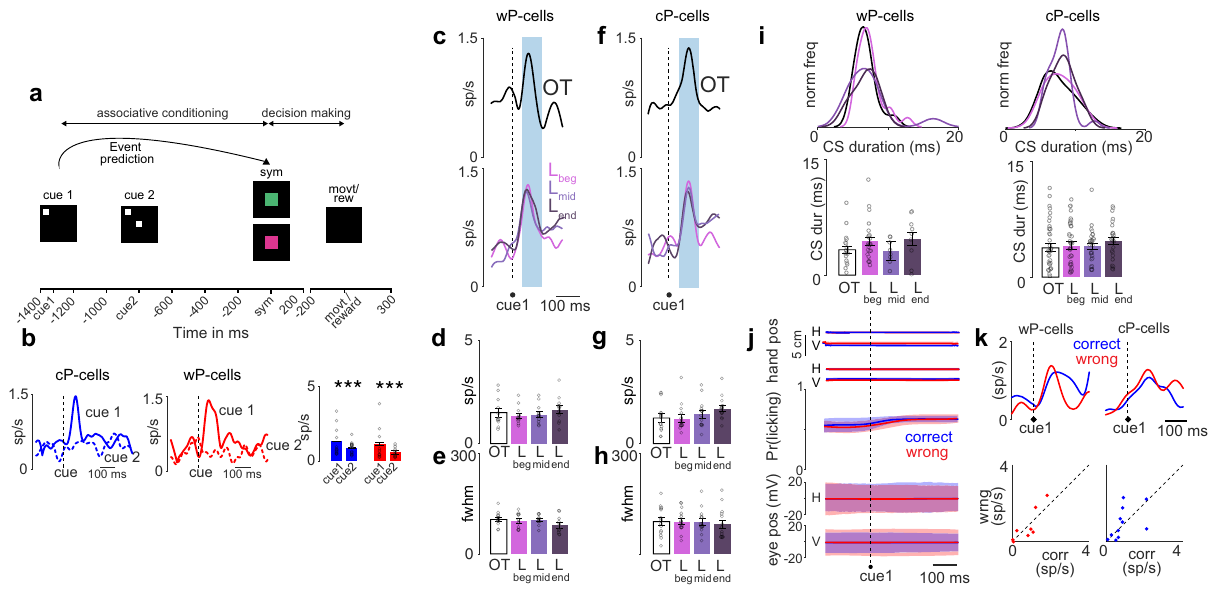
Fig. 4 CS responded to the stimulus that signaled the beginning of the trial but not to a second, temporally paired stimulus. a Trial structure with a schematic of event prediction. b Left: CS activity for cue1 and cue2 for cP-cells (left; blue) and wP-cells (right; red). Right: quantitation from left panel. *** P < 0.001, two-tailed Wilcoxon ranksum test. c Top panel: CS spike density functions in cue1 epoch for wP-cells in the OT condition. Bottom panel: same for wP-cells in L beg , L mid , and L end . n = 11 wP-cells. d Peak fi ring rate of wP-cells in OT, L beg , L mid , and L end conditions for cue1 epoch. n = 11 wP-cells. e Temporal dispersion of CS activity for wP-cells (estimated as the full width at half maximum fi ring rate) in OT, L beg , L mid , and L end conditions in the reward epoch. n = 11 wP-cells. f Same as c but for cP-cells. n = 14 cP-cells. g Same as d but for cP-cells. n = 14 cP-cells. h Same as e but for cP-cells. n = 14 cP-cells. i Left: duration of CS waveforms in OT, L beg , L mid , and L end conditions for wP-cells (left, n = 11 wP-cells) and for cP-cells (right, n = 14 cP-cells). Histograms were normalized on the maximum frequency among all epochs. j From top to bottom: mean horizontal (H) and vertical (V) hand positions of the hand that was associated with the symbol presented, mean H and V hand positions of the hand that was not associated with the symbol presented, mean probability of licking, mean H and V eye position for correct (blue) and wrong (red) trials. n = 25 sessions. k Top: CS activity during L beg for correct (blue) and wrong (red) trials for wP-cells (left) and cP-cells (right). Bottom: scatter plot of peak neural activity for correct and wrong trials for individual wP-cells (left) and cP-cells (right). Data shown as mean ± s.e.m. Source data are provided as a Source Data fi